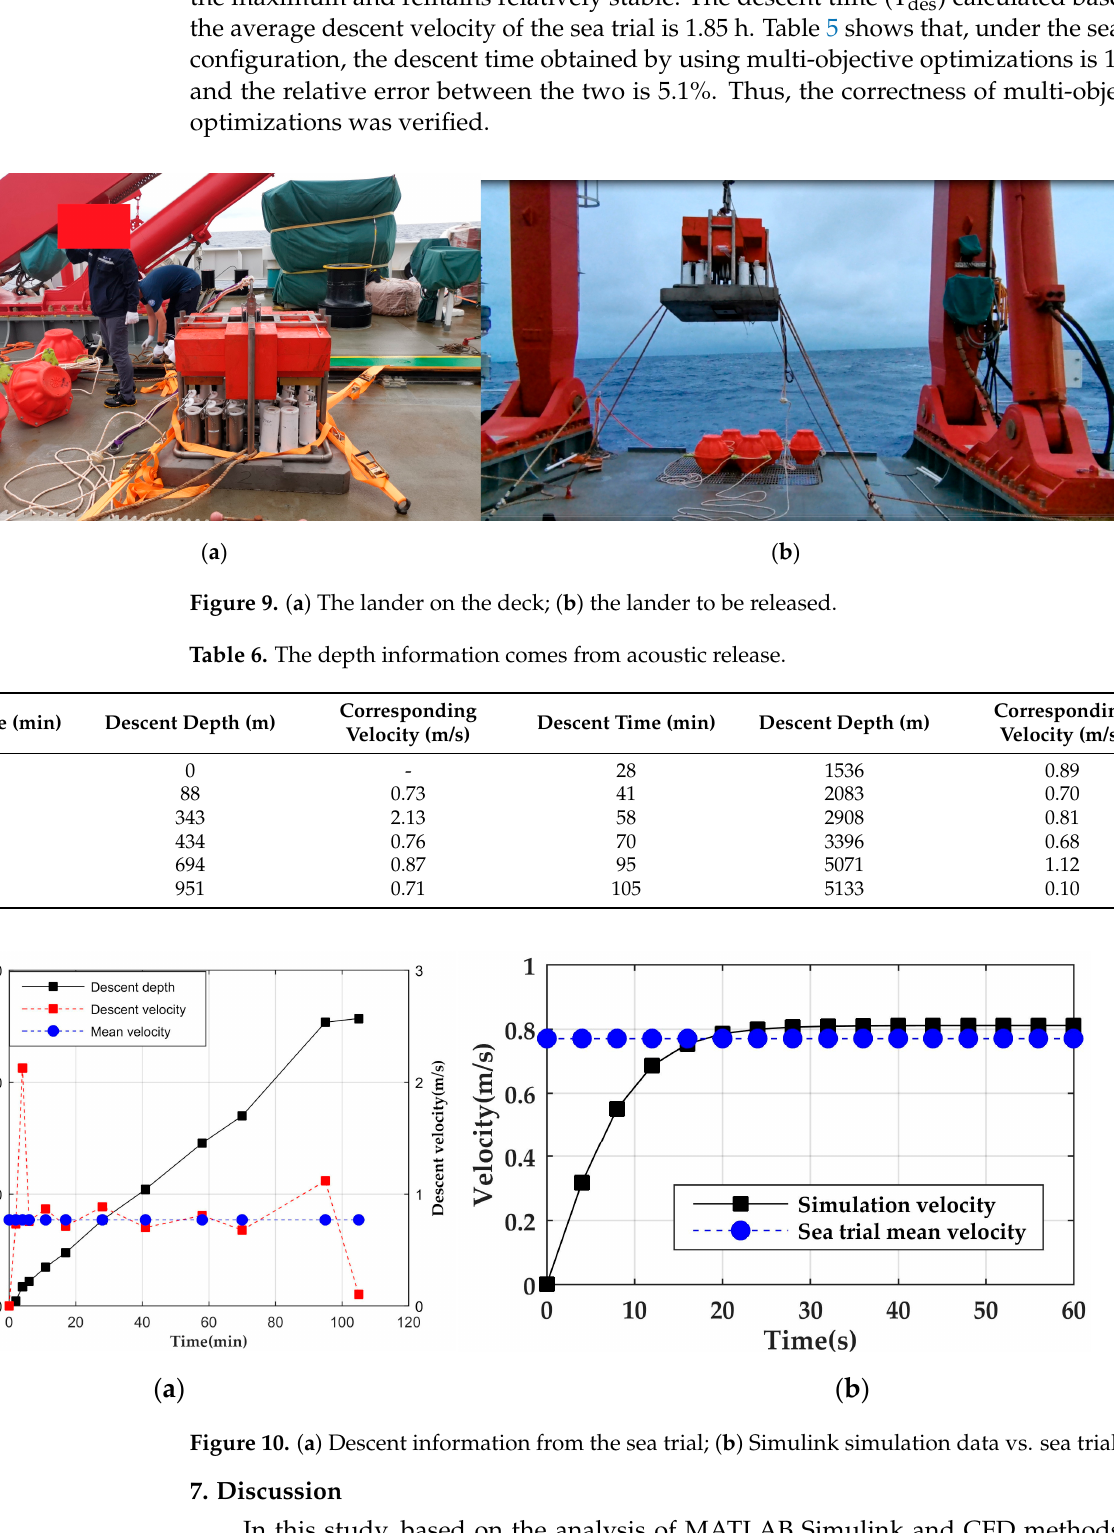
Figure 10. ( a ) Descent information from the sea trial; ( b ) Simulink simulation data vs. sea trial data. 7. Discussion